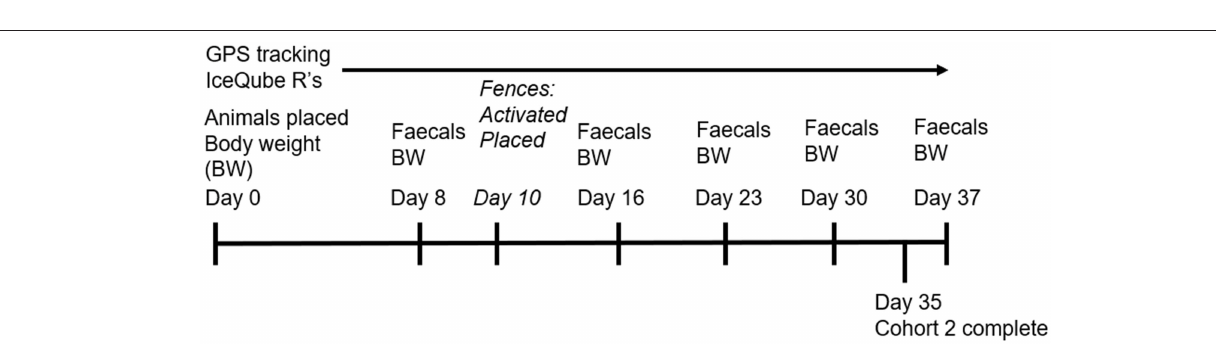
cohort 2. The fences for the two electric tape groups in cohort 2 were shifted to increase paddock size by 1 ha on day 30 of the trial to expose some more pasture for animals in these paddocks for the remainder of the trial as they had shown a decrease in body weight. The virtual fence was not moved as the animals in these paddocks were not exhibiting the same decrease in body